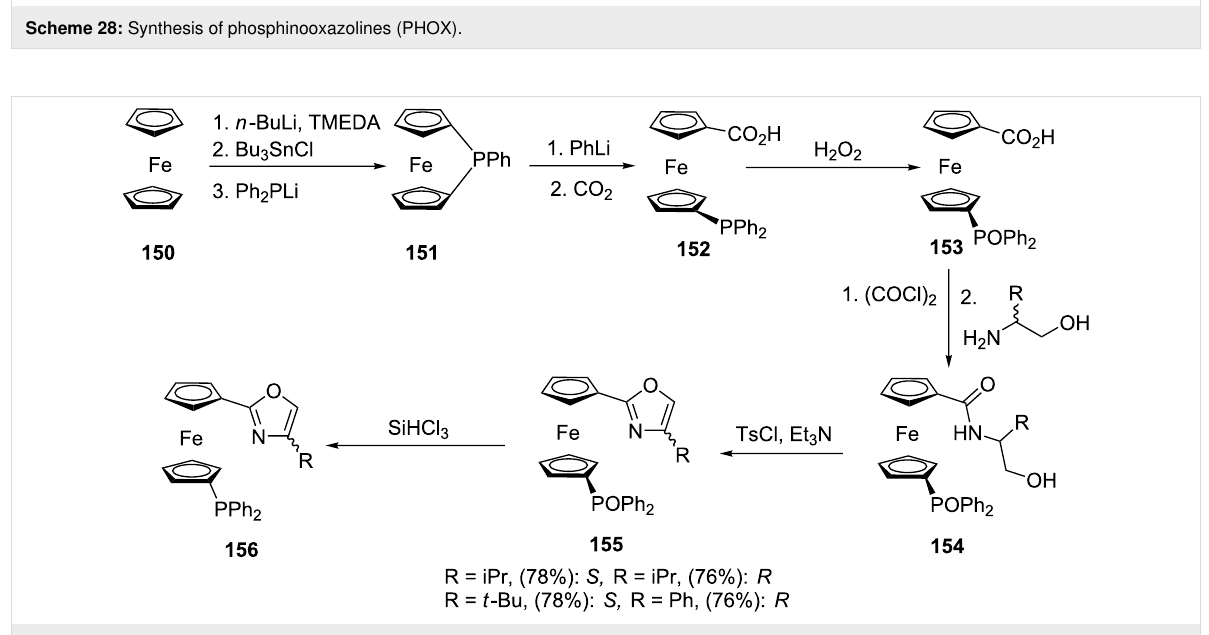
Scheme 29: Synthesis of ferrocenylphosphine